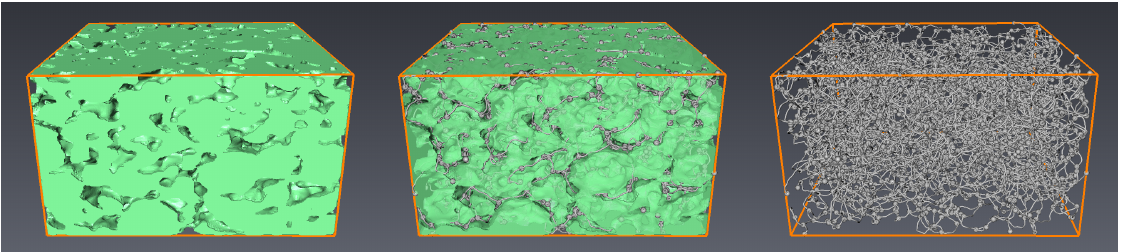
Figure 11. Extraction of the pore space graph via skeletonization from a 3D binary image: binary image ( left ); solid phase and pore space graph ( center ); pore space graph ( right ).